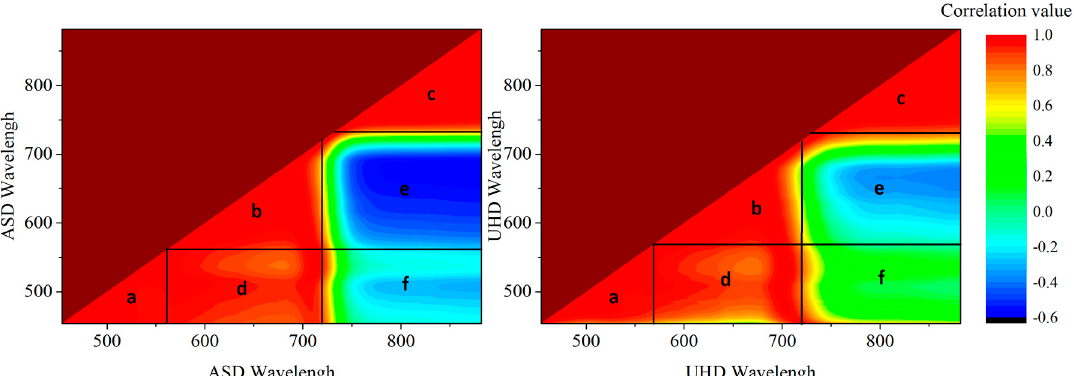
Figure 10. The correlation coefficients among different bands of the UHD 185 and ASD spectrometer. Mostly, Groups a, b and c represent band correlation values greater than 0.9; Group d represents correlation values at 0.7 − 0.9; the correlation values of Groups e and f are less than 0.4.